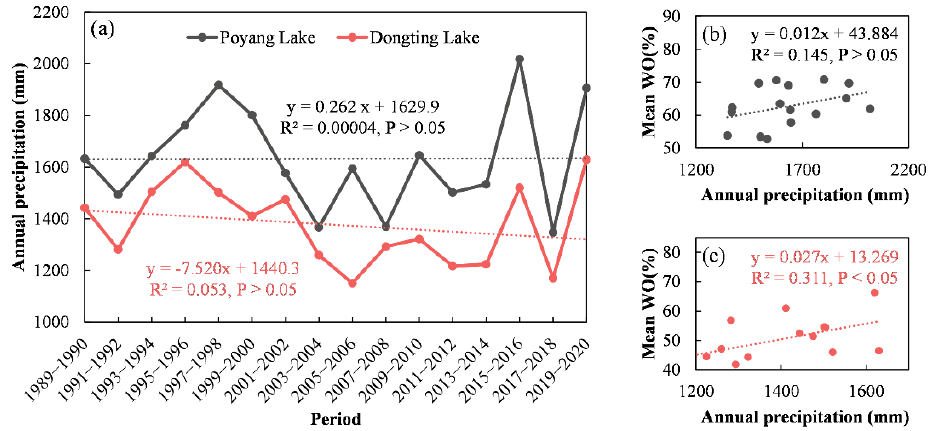
Figure 11. Precipitation changes in Poyang Lake and Dongting Lake. ( a ) indicates the time series of annual precipitation in Poyang Lake and Dongting Lake. ( b ) indicate the relationship between annual precipitation and mean WO in Poyang Lake. ( c ) indicate the relationship between annual precipitation and mean WO in Dongting Lake.